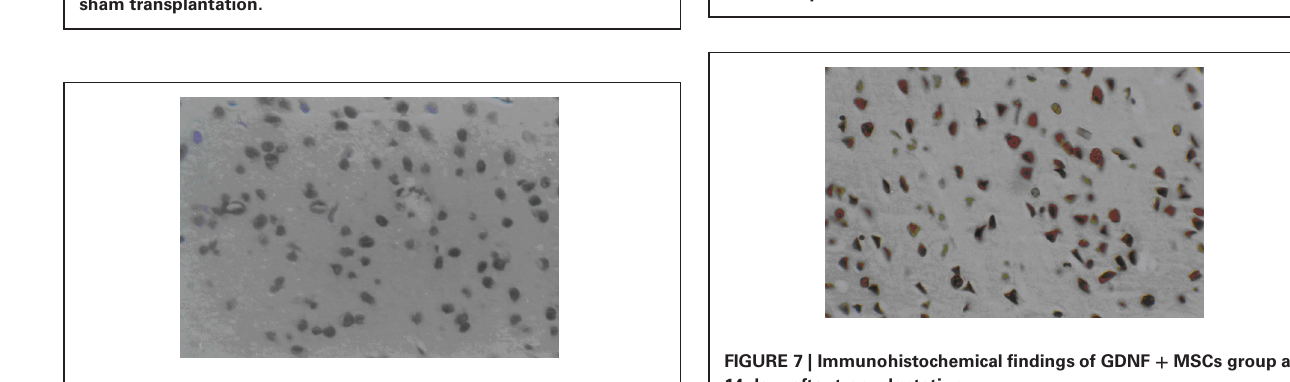
FIGURE 4 | TUNEL findings of MSCs group at 28 days after transplantation.